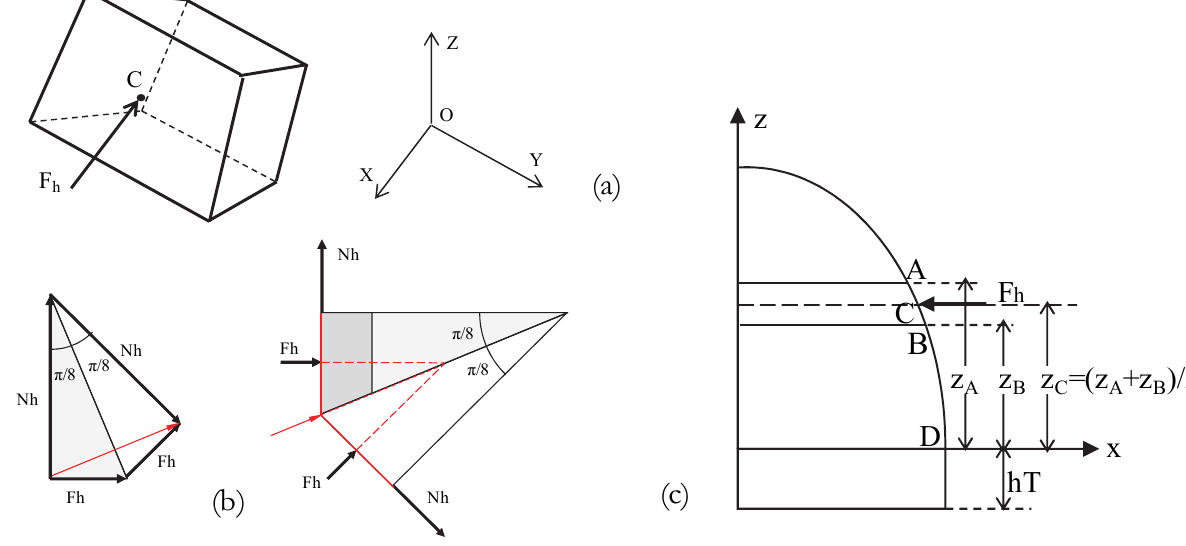
Figure 5: Force depending by the hoop. (a) The resultant force F h ; (b) N h pretension effort and F h resultant force; (c) Level of C application point of F h